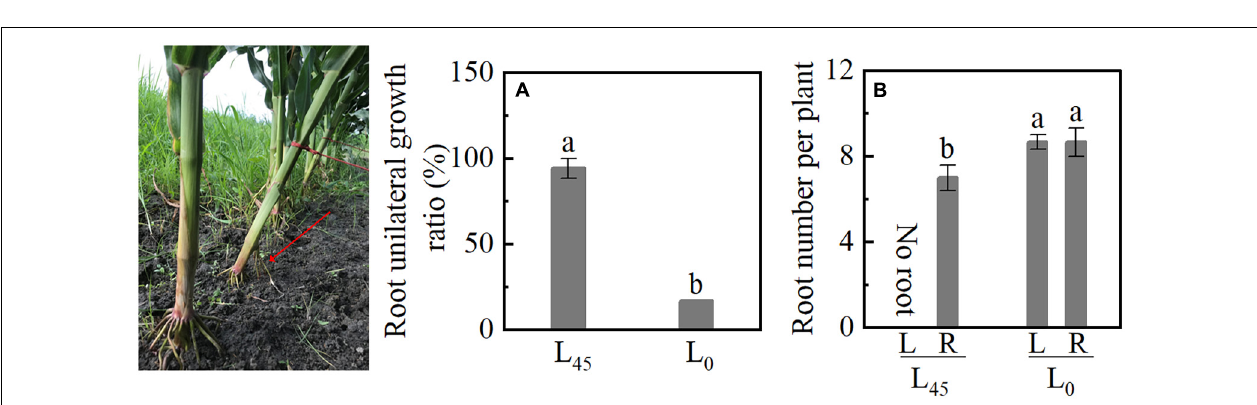
FIGURE 7 | Plant inclination and brace unilateral root growth ratio of a split-root experiment in Study 2. SI 20 : the narrow and wide row spacing of 20 + 200 cm of intercropping maize; SI 40 : the narrow and wide row spacing of 40 + 180 cm; SI 60 : the narrow and wide row spacing of 60 + 160 cm; SM: monoculture maize. (A) Plant inclination of maize; (B) the brace unilateral root growth ratio. (C) The number of brace roots in narrow row and wide row with intercropping and left and right sides of monoculture. Data with the different letters are significantly different ( p < 0.05).